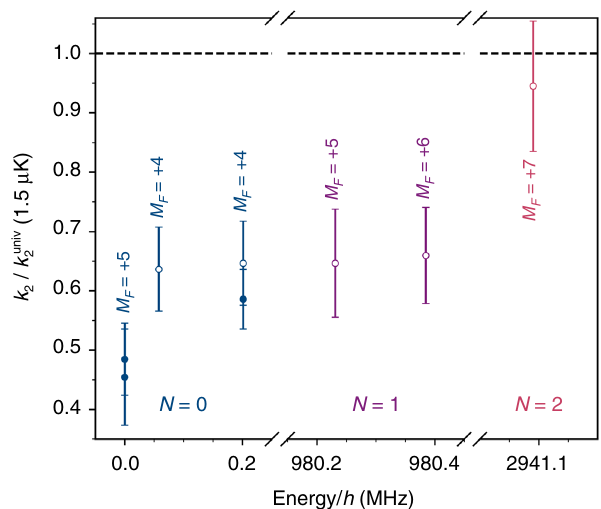
Fig. 4 Loss rates as a fraction of the universal limit in a range of rotational and hyper fi ne states. Molecules are prepared in a state ( N , M F ) with T = 1.5 (1) μ K. The energy of each state is given relative to that of (0, + 5). fi lled circles are measurements where the state is populated directly by STIRAP, whereas empty circles show where the molecules are transferred to the state with coherent microwave π -pulses (see methods). Error bars show the 1 σ uncertainty in the measured rate constant k 2 . Numerical values for the results are given in Supplementary Table 1